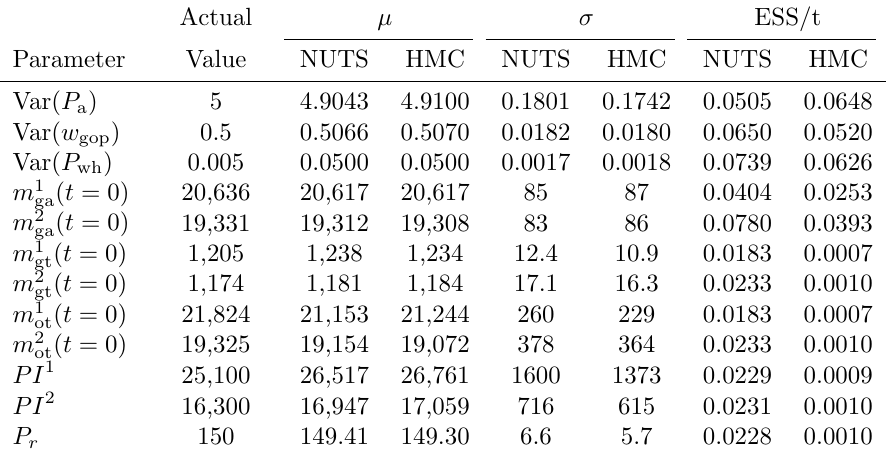
Table 2: Comparison of NUTS and HMC, posterior statistics.